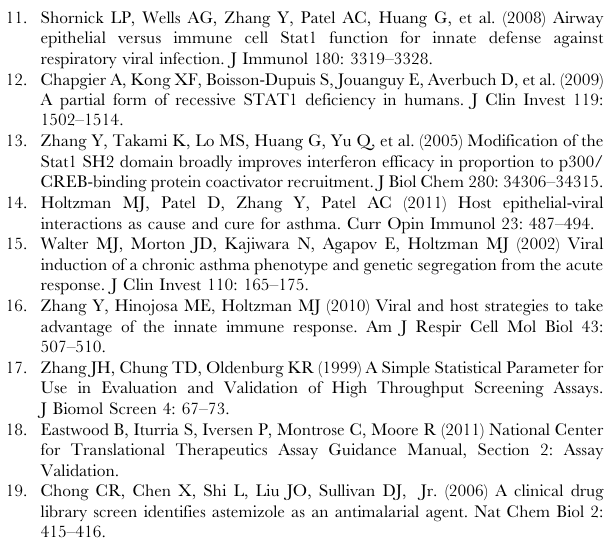
Figure S1 Miniaturization and automation of the ISRE activity assay. (A) Effect of cell density on ISRE activity as a function fo IFN- b concentration in 384-well plates. B) Well-to-well reproducibility for the assay performed in 384-well automated format using 8000 cells per well. Figure S2 Scheme for the HTS automation protocol. Each box represents one of the sequential steps in the screening process. Timing and time allotment for each step is also